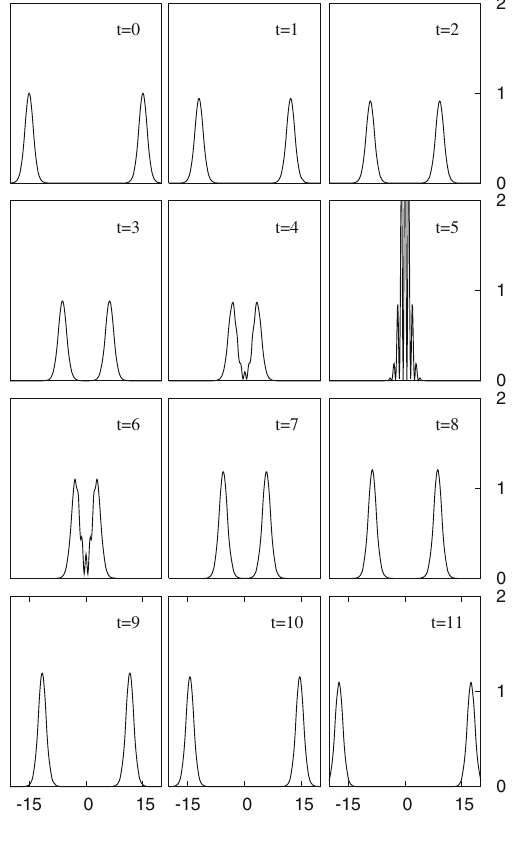
Fig. 16 Collision of identical boson stars with large kinetic energy in the Newtonian limit. The total energy (i.e., the sum of kinetic, gravitational and self-interaction) is positive and the collision displays solitonic behavior. Contrast this with the gravity-dominated collision displayed in Fig. 17.